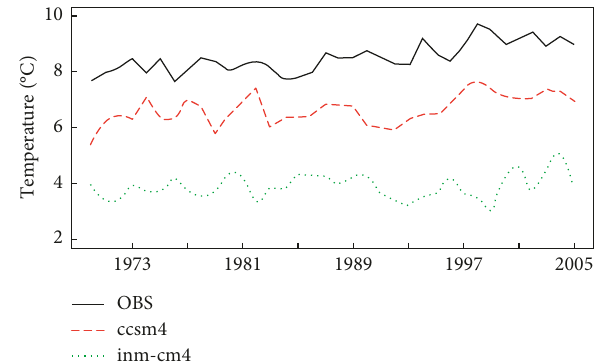
Figure 5: Annual temperature changes in the Yellow-Huai-Hai